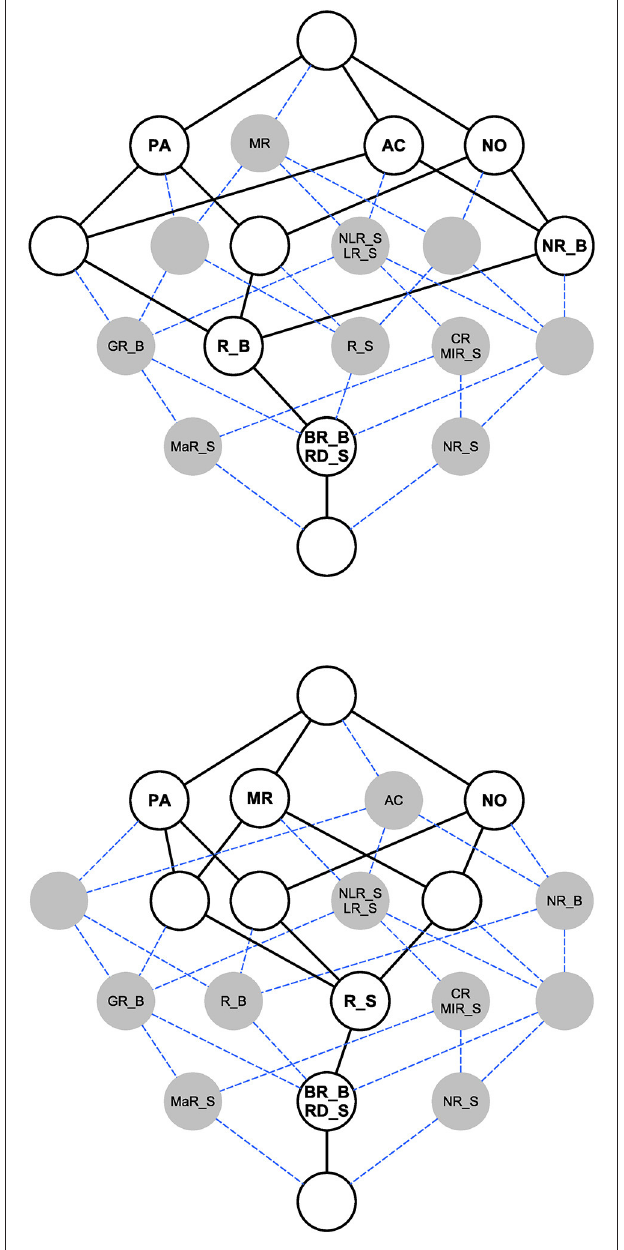
FIGURE 3 | (Top) Part of the lattice linked with the CBD “resource” expression (label R_B); (bottom) Part of the lattice linked with the UNCLOS “resource” expression (label LR_S). Reduced representation, see Figure 2 (figures built with the free software Concept Explorer 1.2;